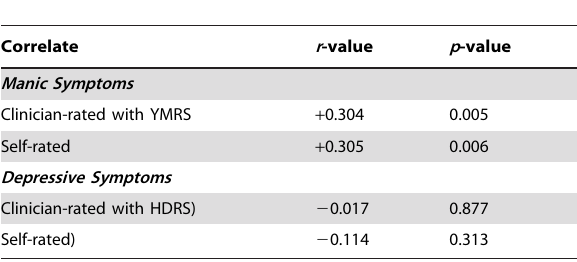
Table 1. Correlations of individual values of vulnerability index (VI) with self- and clinician-ratings of manic and depressive